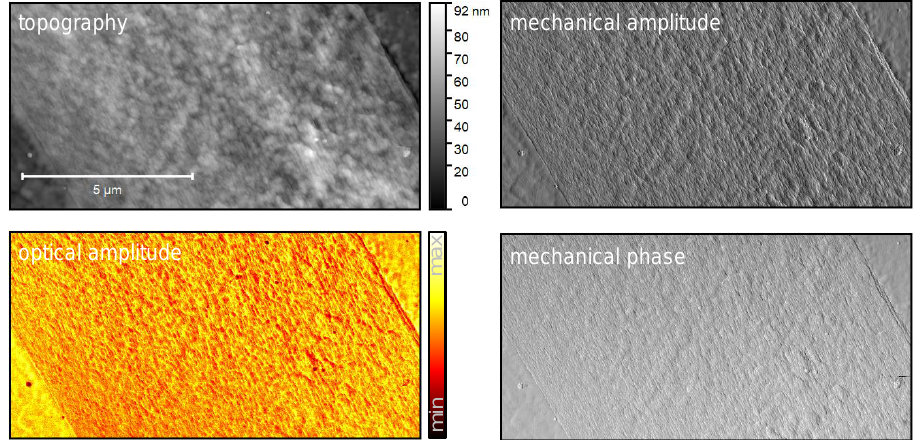
Figure 2. Raw SNOM (neaspec) data from a longitudinal slice of Bombyx mori silk: topography (height: 0–92 nm), mechanical amplitude and phase, and optical amplitude (proportional to the reflectivity integrated over 1300–2020 cm − 1 ) IR spectral